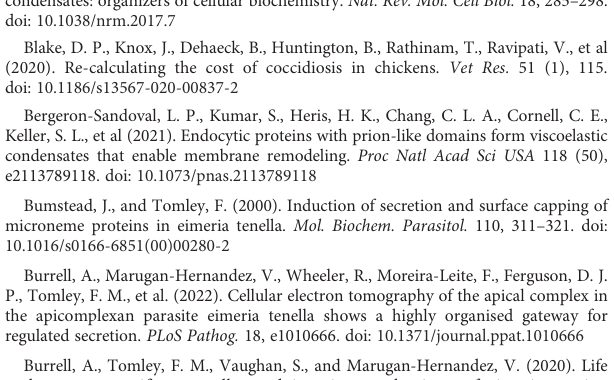
SUPPLEMENTARY FIGURE 1 Refractile body merger is associated with sporozoite roundness. (A, B) : Light microscopy data of a sporozoite with 2 RB fi xed at 5 hpi Cell length (yellow) and cell width (cyan) were measured. The RBant. (arrowhead) visualised using Nile Red. (C, D) : Light microscopy data of a sporozoite fi xed at 5 hpi where merger has occurred. Note the absence of RBant. in (D) . (E) . Comparison of length/width values for presence or absence of an RBant. at 5 hpi (n = 17). Mean length/width value for sporozoites with an RBant. was 2.41 compared to mean length/width value of 1.95 in sporozoites where merger has occurred (p = 0.013, T-test). SUPPLEMENTARY FIGURE 2 Analysis of Host cell actin following treatment with actin inhibitors. Following Phallodin Atto 488 staining at 5hrpi, control host cells (DMSO) exhibited numerous intact actin fi laments. Host cells treated with 200 nM CytoD, contained intact actin fi laments and some granularity throughout the cytoplasm. Host cells treated with either 1µM CytoD or 200 nM LatA showed comparable actin staining patterns and both contained faint fi laments, lower in density than for those treated with 200 nM CytoD or control, and had a granular pattern throughout the cytoplasm. Host cells treated with 500 nM LatA exhibited the most disruption to actin- fi lament structure. Scale bar ≈ 20µm MOVIE 1 Live cell imaging of RB merger 63X. See methods for